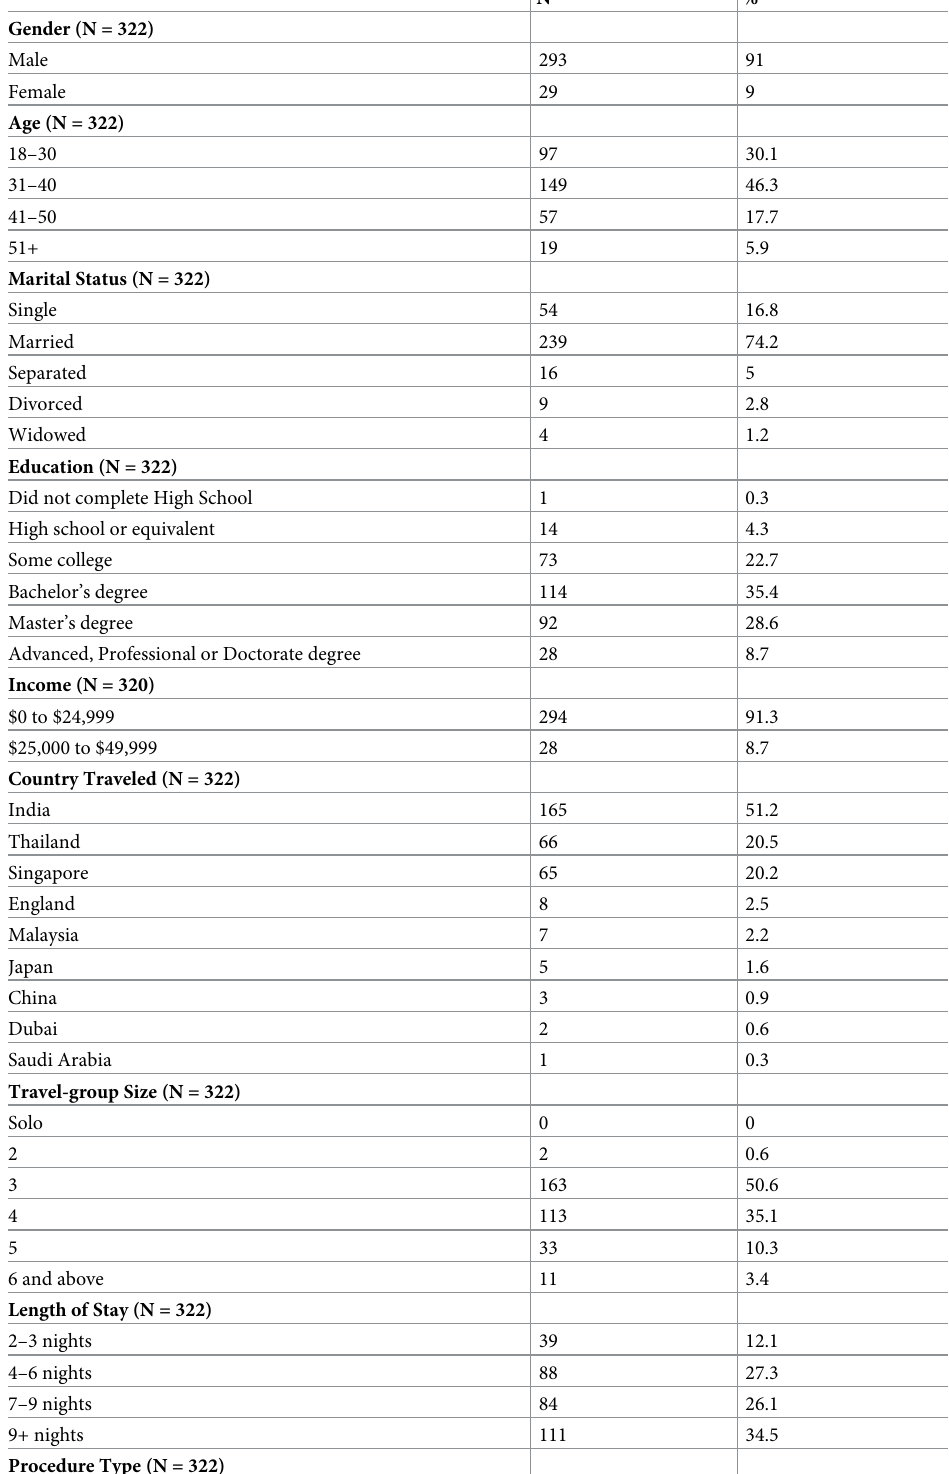
Table 1. Respondents’ demographic